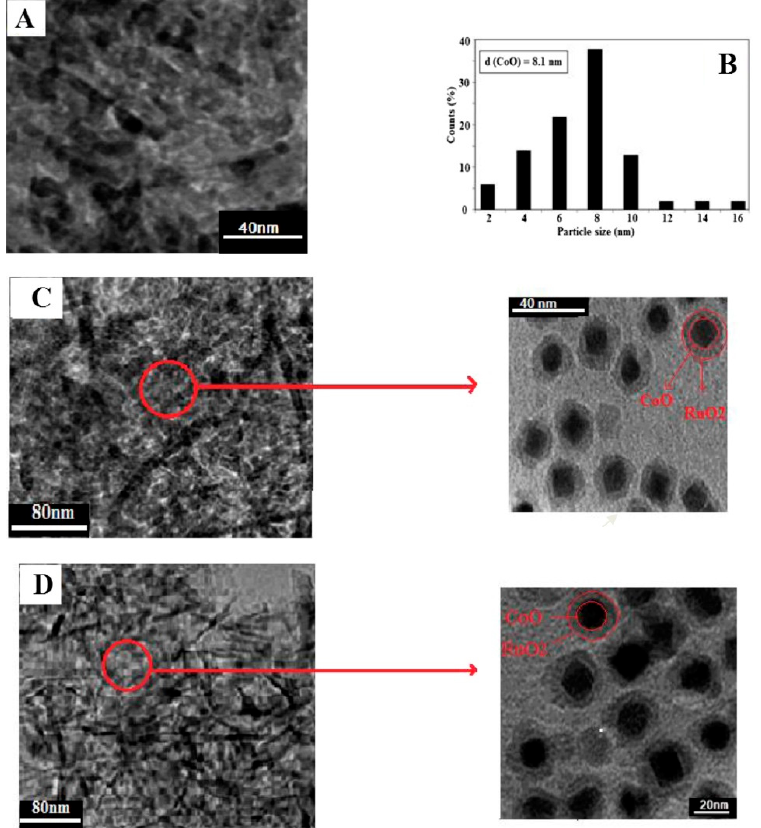
Figure 11. High-resolution TEM (HRTEM) image of 5Co/ γ -Al 2 O 3 ( A ), cobalt oxide particle size histogram of 5Co/ γ -Al 2 O 3 ( B ), HRTEM image of 5Co-0.55Ru/ γ -Al 2 O 3 ( C ), HRTEM image of 5Co-2.14Ru/ γ -Al 2 O 3 ( D ). Reprinted with permission from [79]. Copyright (2014) Pergamon-Elsevier Science LTD., Oxford, England.